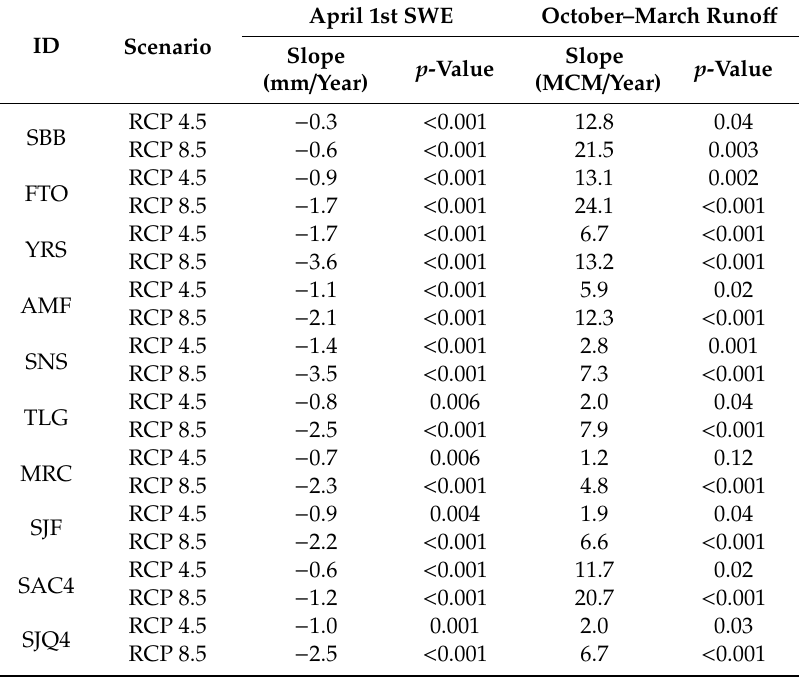
Table 6. Trend slope and corresponding p -values for mean projections on April 1st snow water equivalent (SWE) and October–March runo ff